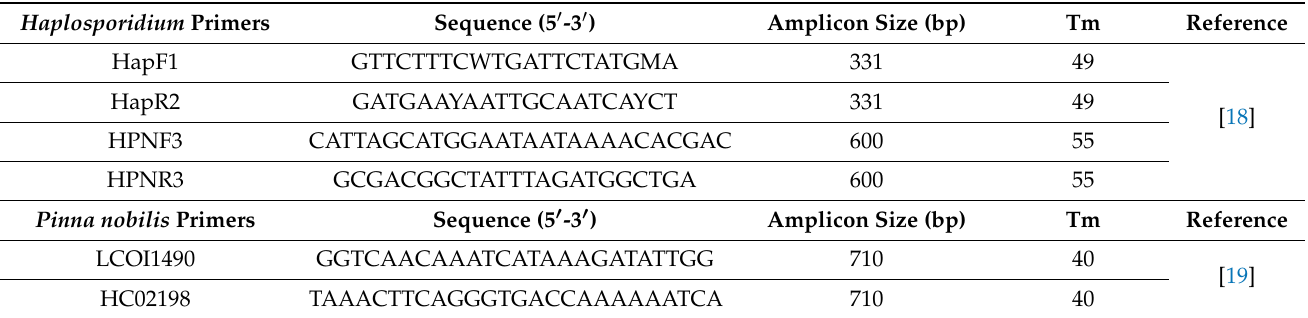
Table 2. Primers used in this study for PCR amplification of DNA from Haplosporidium pinnae and Pinna nobilis